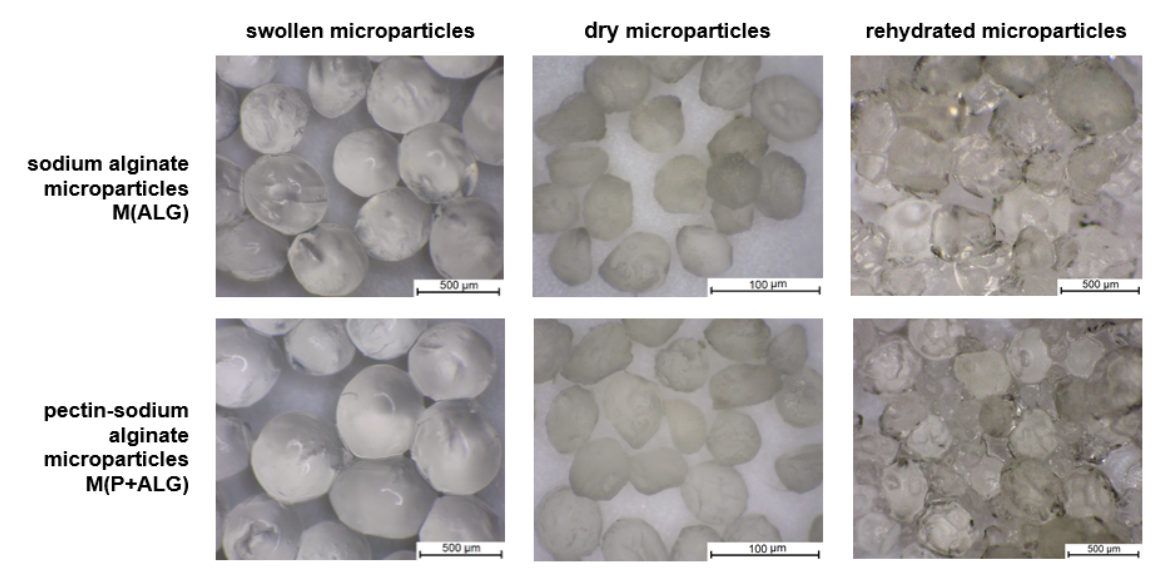
Figure 2. Optical microscope images of sodium alginate and pectin-sodium alginate microparticles containing surfactant for swollen, dry, and rehydrated particle forms.